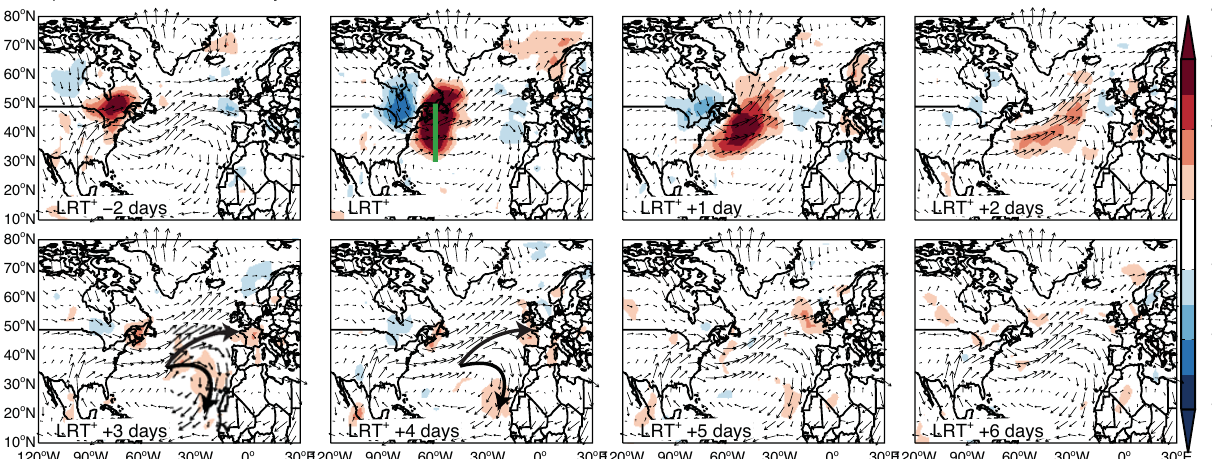
b) Evolution of composite AOD anomalies: MODIS